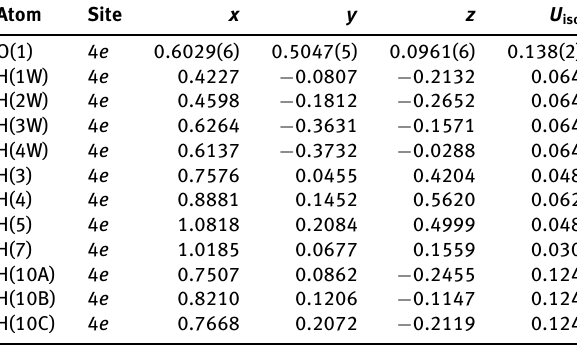
Table 2: Fractional atomic coordinates and isotropic or equivalent isotropic displacement parameters (Å 2